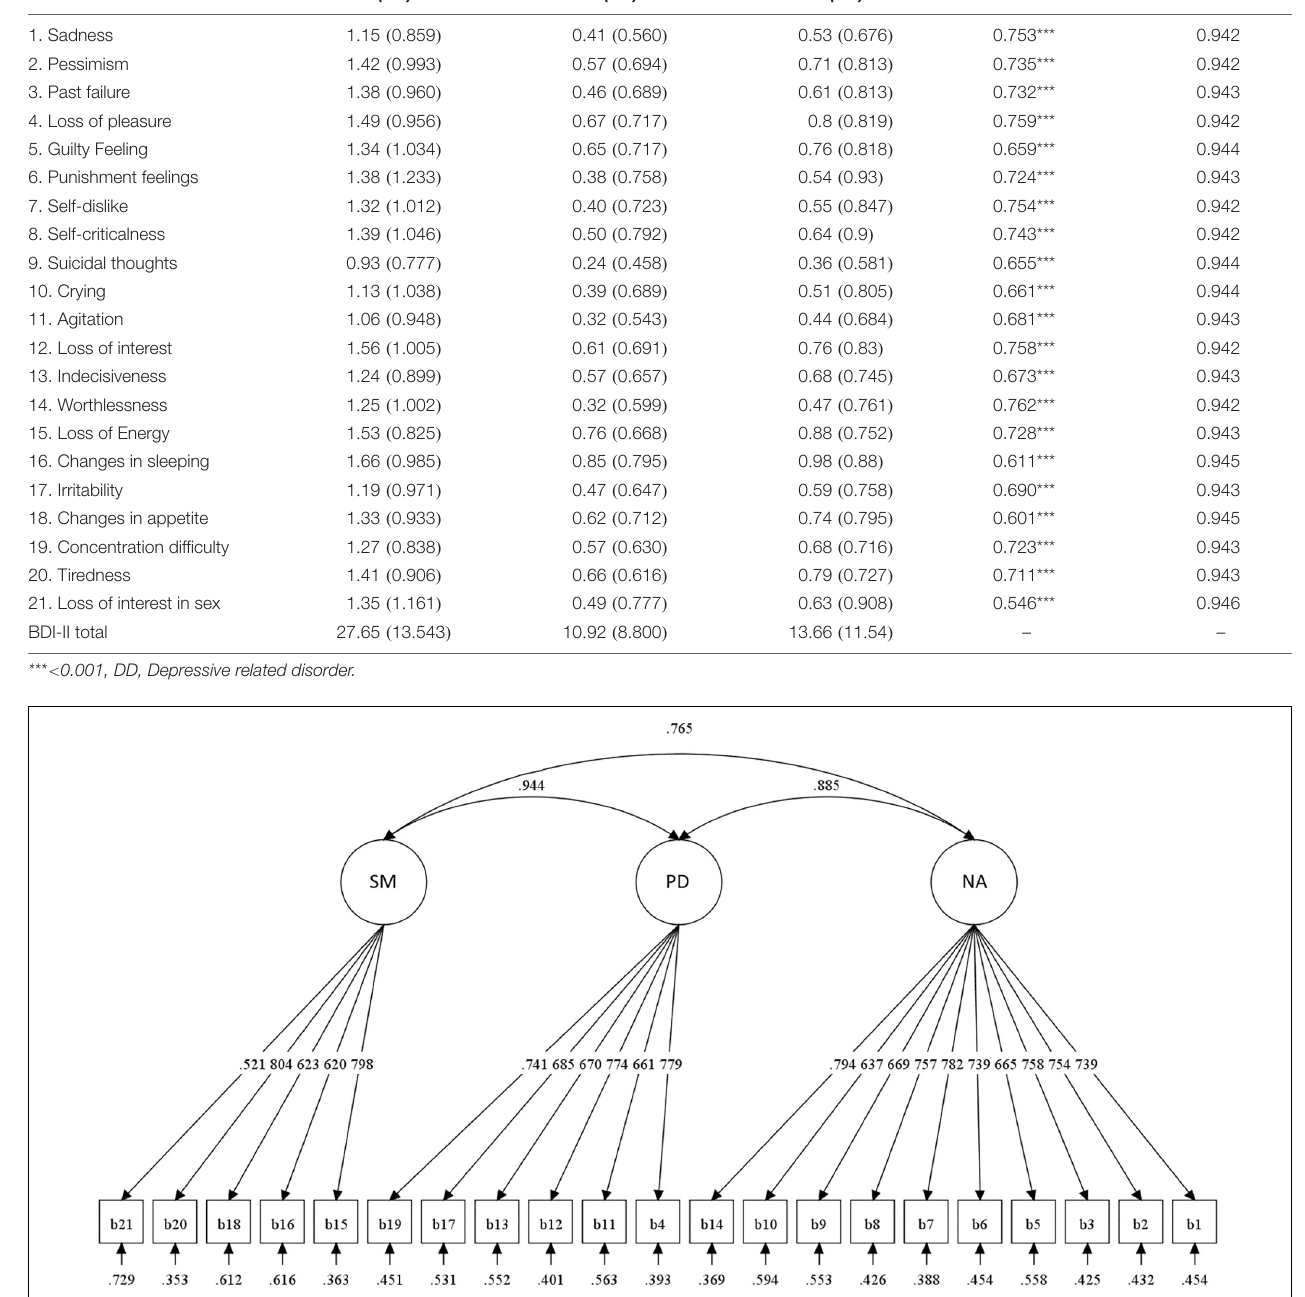
FIGURE 1 | Diagram of confirmatory factor analysis for 3-factor model. SM, Somatic Factor; PD, Performance Difficulty Factor; NA, Negative Attitude Factor.